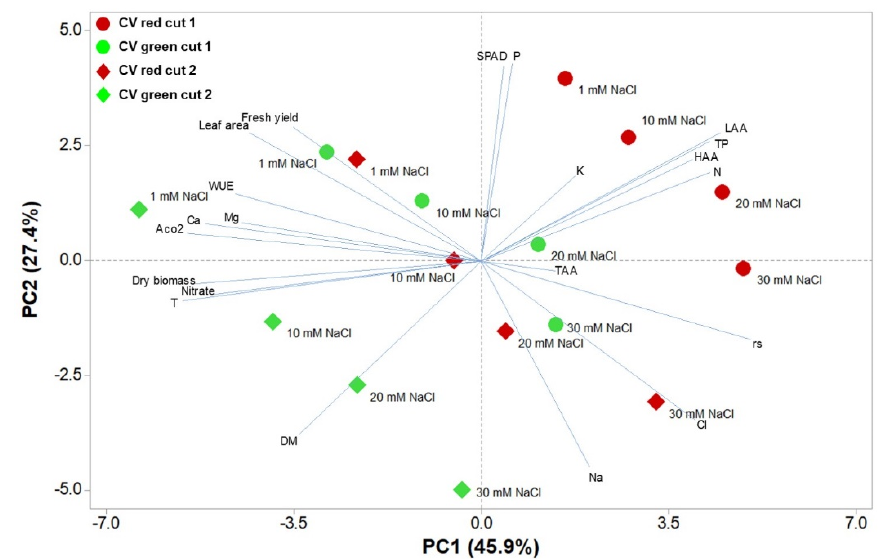
Figure 1. Principal component loading plot and scores of principal component analysis (PCA) of morphological parameters, mineral composition, leaf gas exchanges, bioactive compounds, and antioxidant activity of green and red pigmented lettuces under four salinity levels (1, 10, 20 and 30 mM NaCl) and two successive harvests. T: transpiration rate, DM: lead dry matter percentage, TAA: total ascorbic acid, r s : stomatal resistance, HAA: hydrophilic antioxidant activity, LAA: Lipophilic antioxidant activity, SPAD: soil plant analysis development, WUE: water use efficiency, A CO2 : net CO 2 assimilation rate.